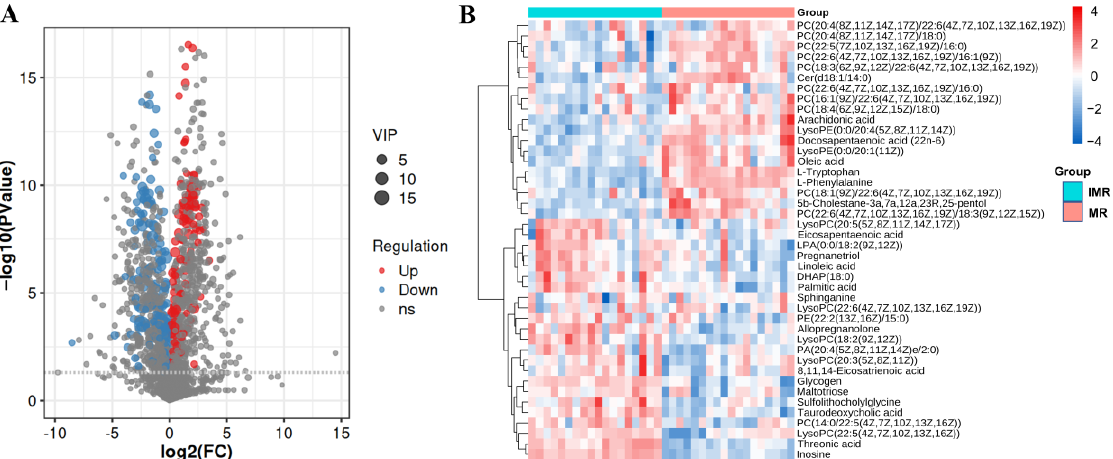
Figure 3. The hepatic differential metabolites change between immature female rainbow trout and mature females. ( A ) Volcano map of the DMs. ( B ) Heat map visualization of the DMs.